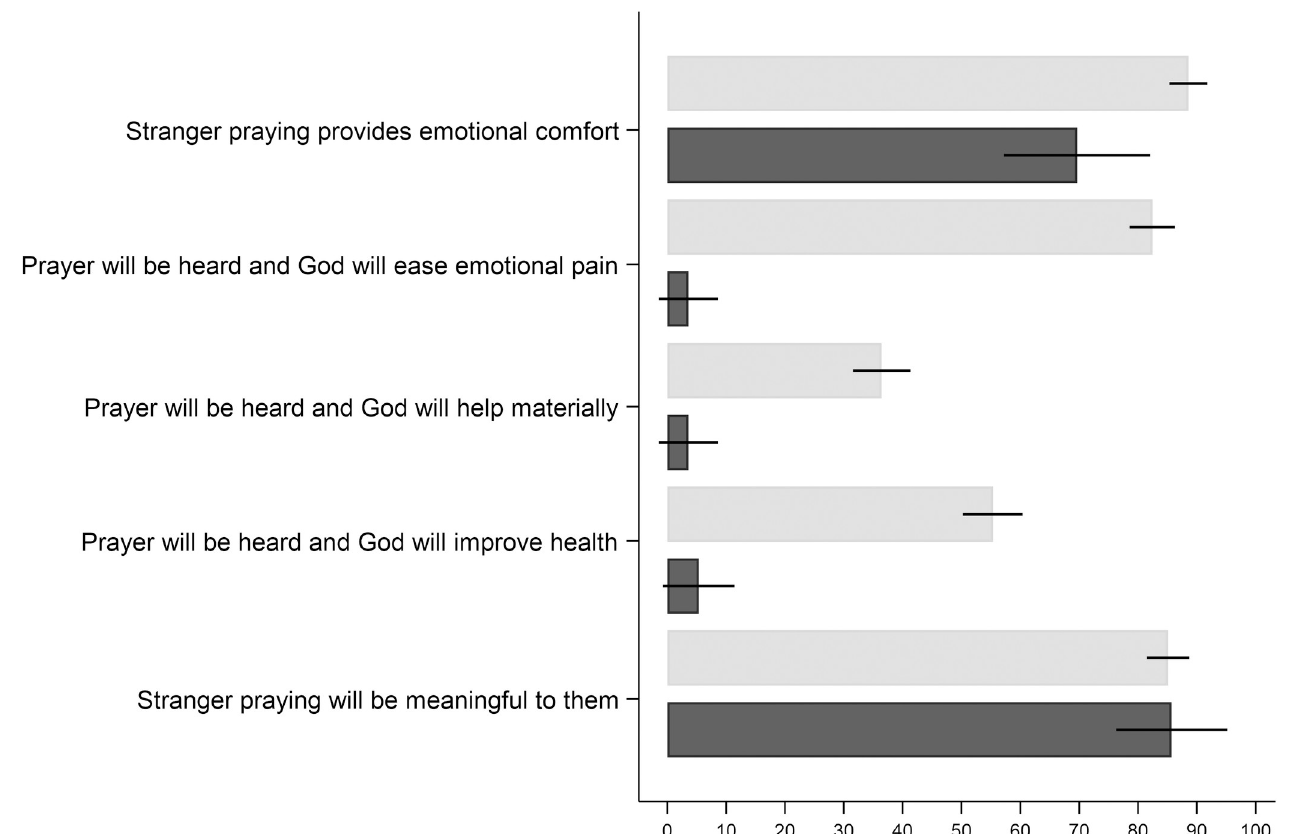
Fig 2. Share that agrees with factors that contribute to the positive value of the prayer; Christians (light grey) and non-believers (dark grey). Note: Error bars represent 95% confidence